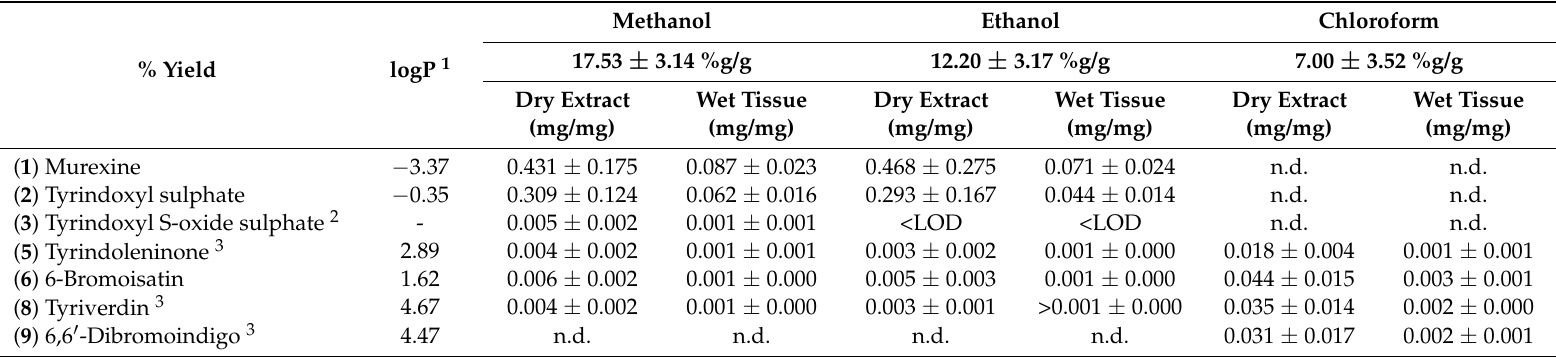
Table 2. Yield of solvent extracts (% w / w ) from the hypobranchial glands D. orbita and the mean ( ± SD) weight of precursor compound, as a proportion of the total extract weight (mg/mg) and weight of wet hypobranchial tissue prior to extraction (alcoholic extracts: n = 4; chloroform extracts: n =